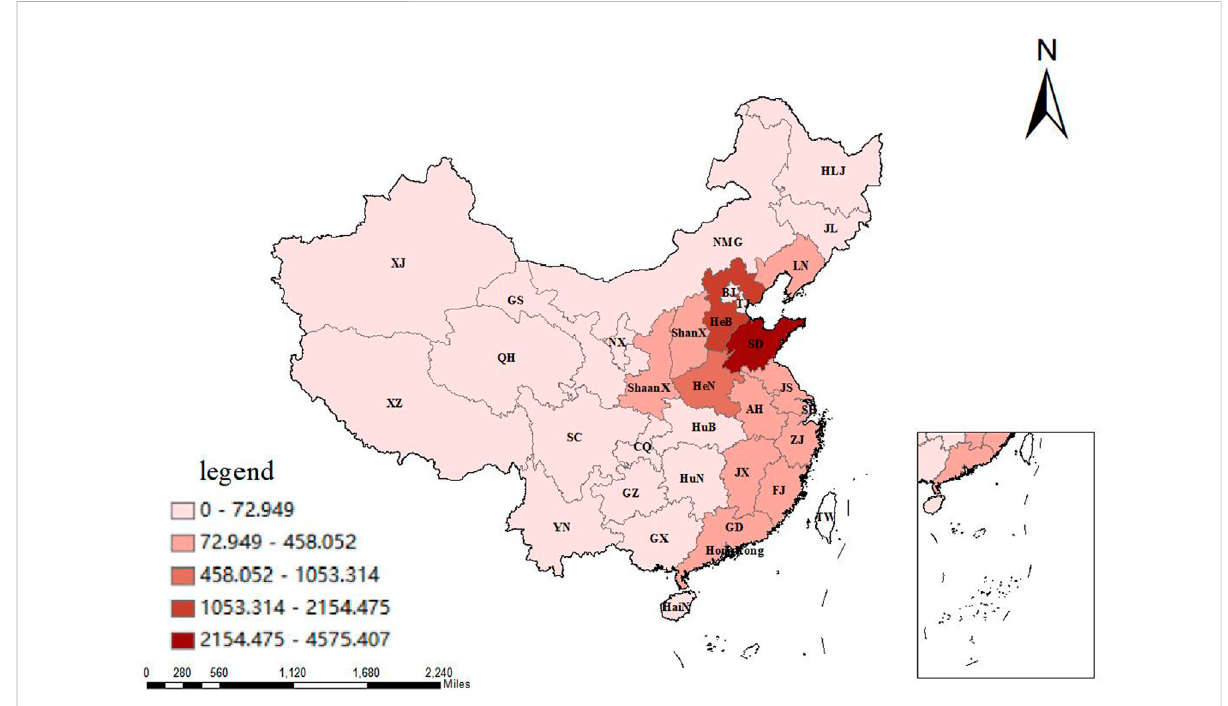
FIGURE 2 2021 Installed capacity of household PV projects in China (MW).